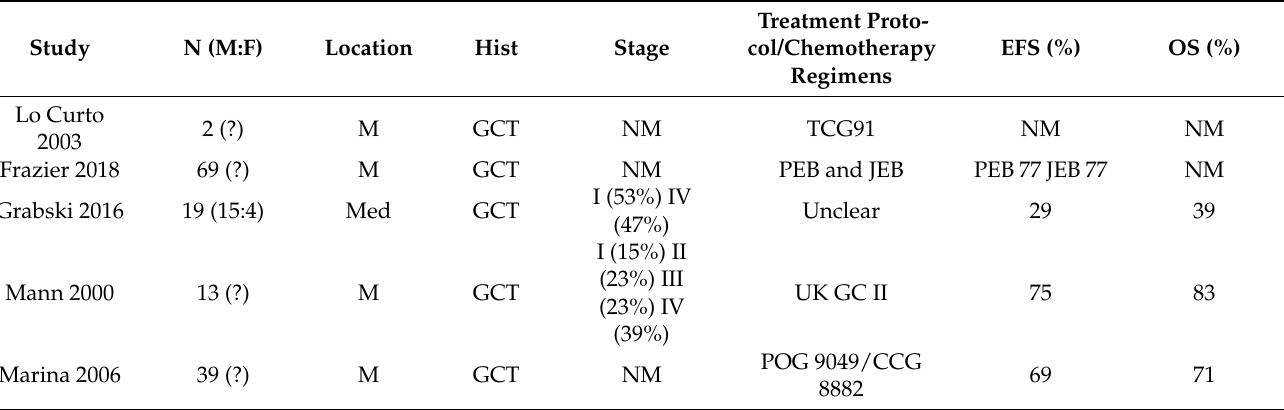
Table 3. Details on the studies of mediastinal